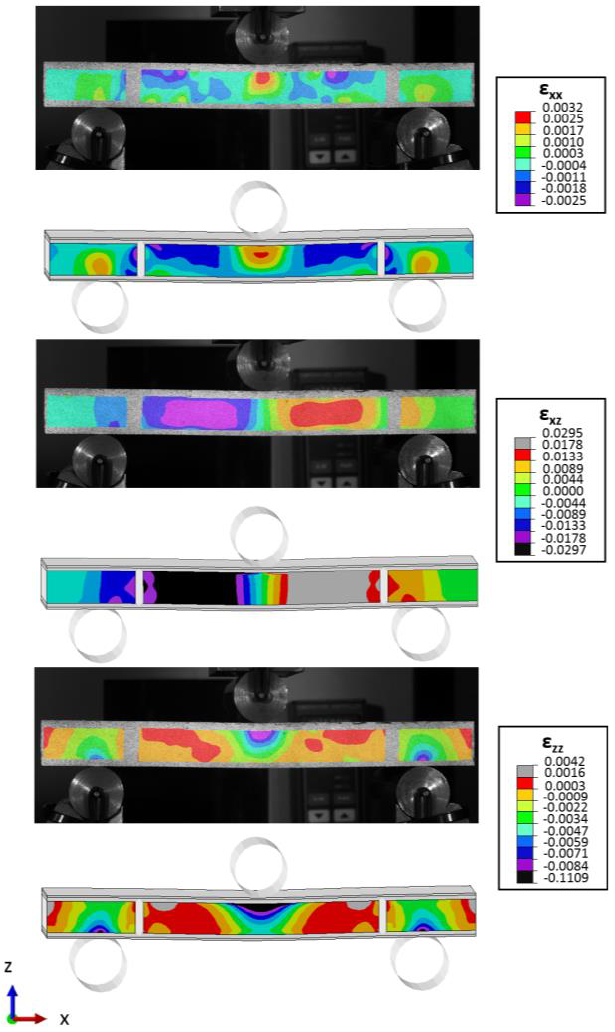
Figure 14. Comparison between DIC and FEA strain contours (applied displacement of 1.5 mm) for ‘Configuration 3′ . For each component of strain, the experimental (DIC) result is shown first.